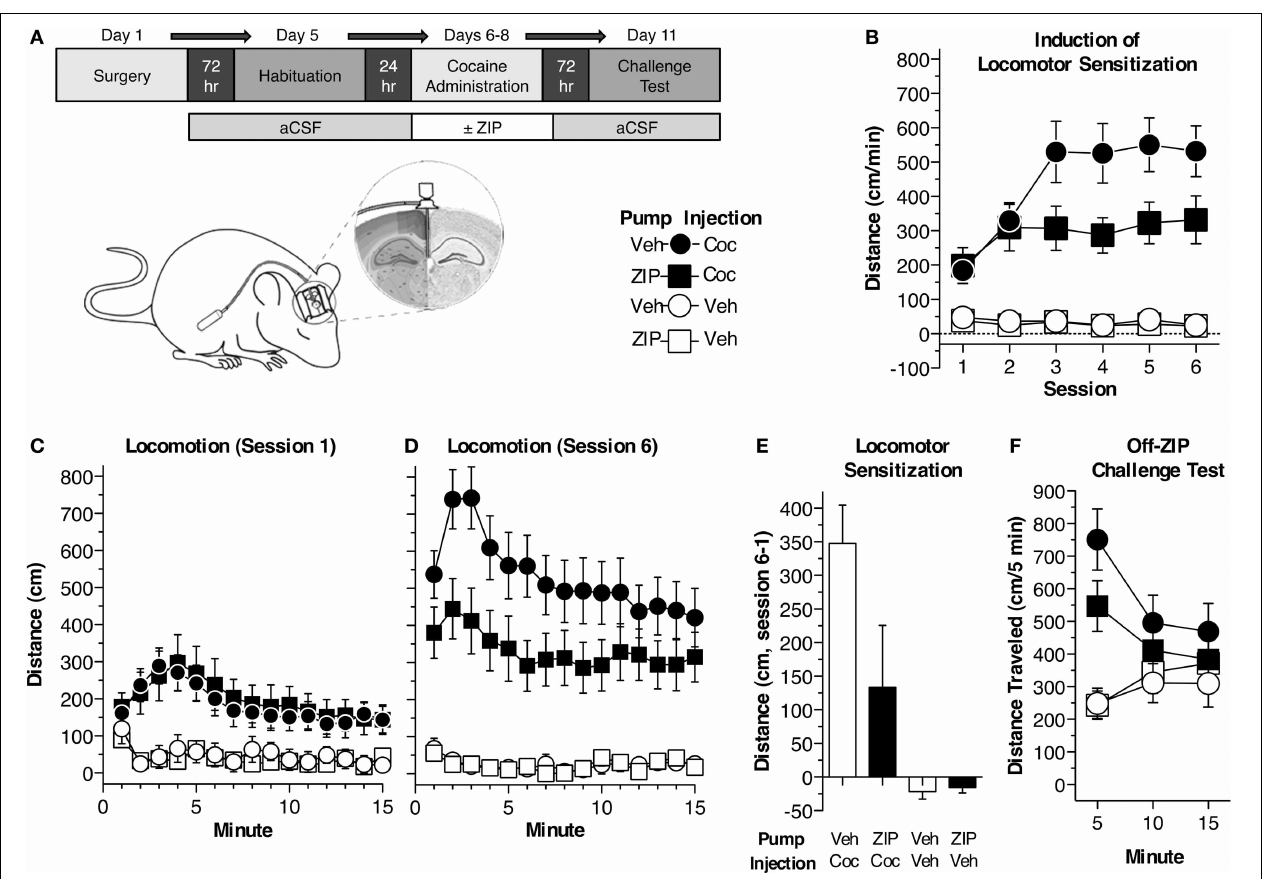
FIGURE 1 | Continuous ZIP administration blocks cocaine-induced locomotor sensitization. (A) Depiction of the procedure used in experiment 1 ( n = 10 Veh/Coc, n = 11 ZIP/Coc, n = 7 Veh/Veh, n = 8 ZIP/Veh). Mice were implanted with osmotic pumps, filled such that ZIP would be delivered ICV just prior to the first cocaine administration session and terminate 24h following the sixth session (10nmol, 0.25 μ L/h). Animals underwent six cocaine administration sessions (2 sessions per day) during which time the development and expression of sensitization was assessed. (B) ZIP impaired the development of sensitization. The data represent the average distance traveled for each session ( ± s.e.m.). The distance traveled by mice receiving ZIP/Coc was reduced compared to mice treated with Veh/Coc across the six cocaine administration sessions [15mg/kg, i.p.; MANOVA, F ( 3 , 32 ) = 18 . 3, p < 0 . 001; Fisher’s PLSD p < 0 . 05]. ZIP alone did not produce any locomotor attenuating effects (ZIP/Veh, Veh/Veh, p = 0 . 93).